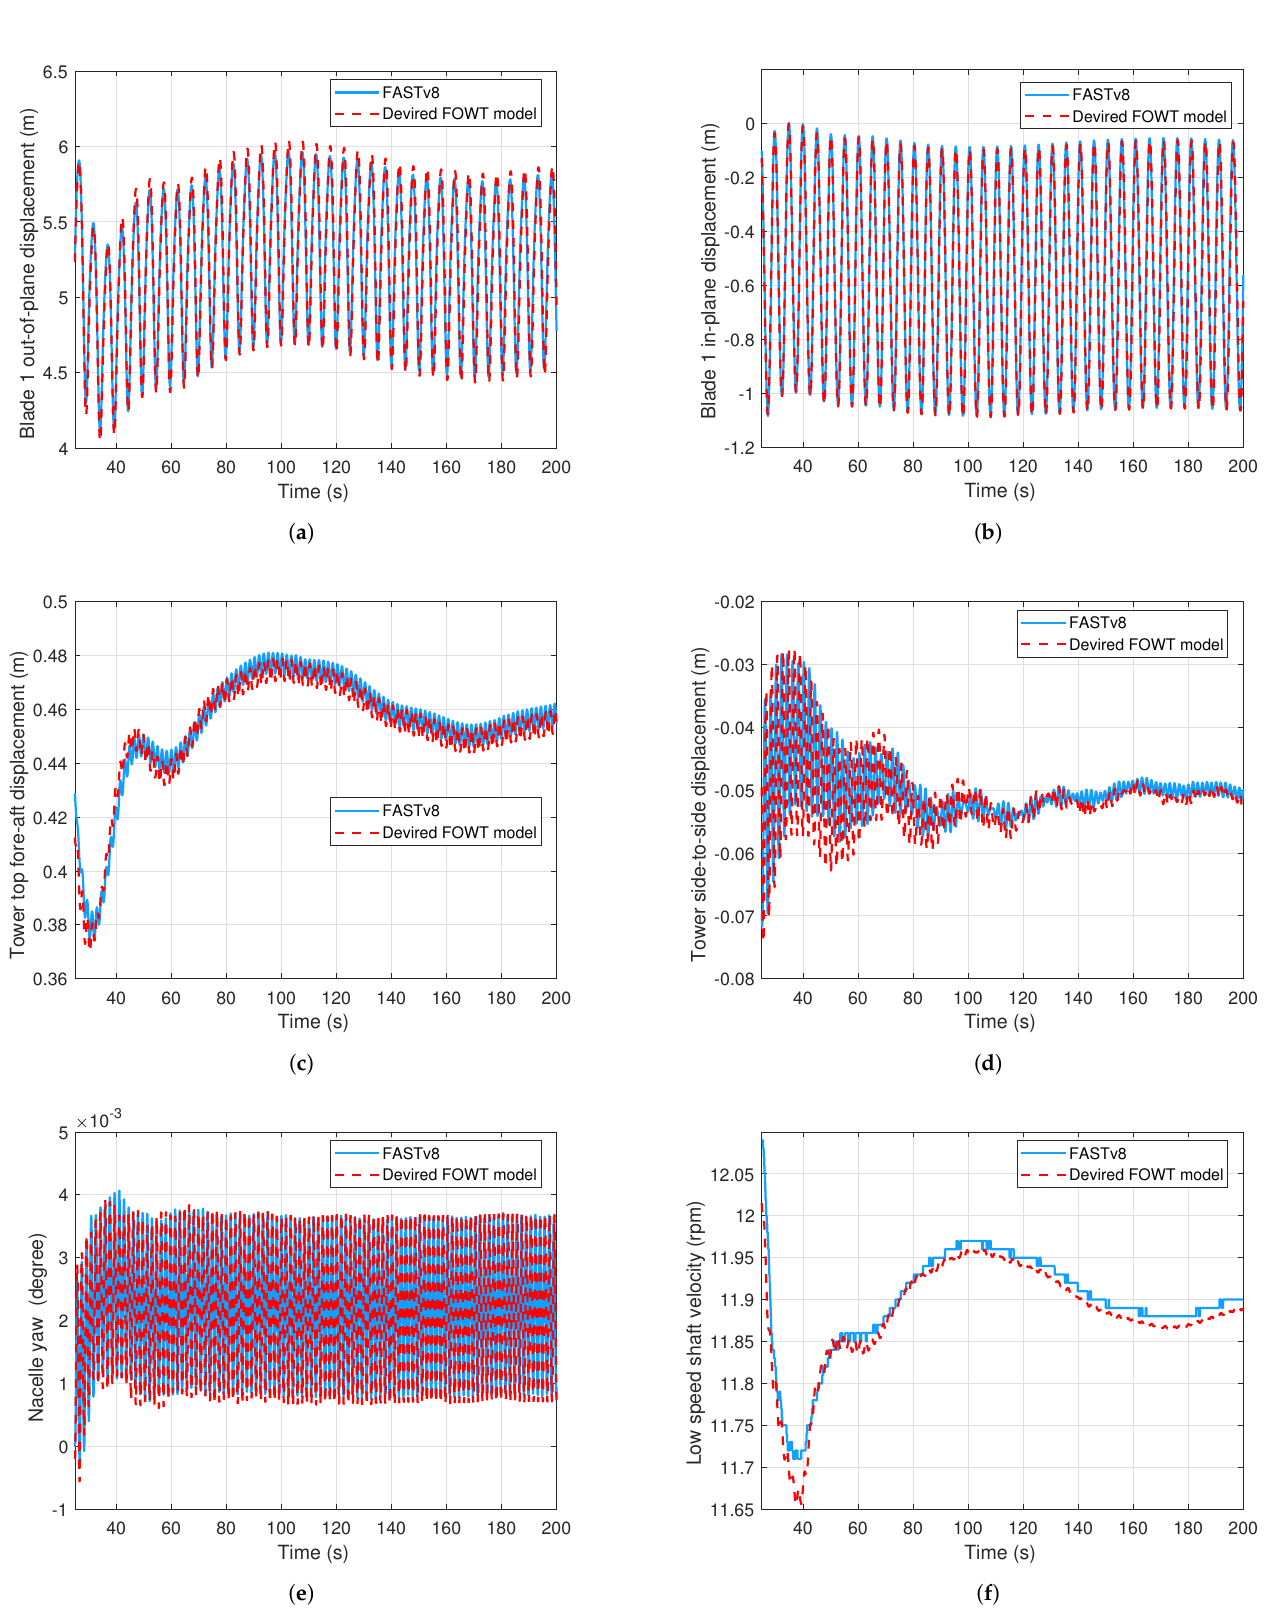
Figure 8. Model verification: motion of the floating offshore wind turbine. ( a ) Blade 1 out-of-plane displacement; ( b ) Blade 1 in-plane displacement; ( c ) Tower top fore-aft displacement; ( d ) Tower to side-to-side displacement; ( e ) Nacelle yaw rotation; ( f ) Low speed shaft